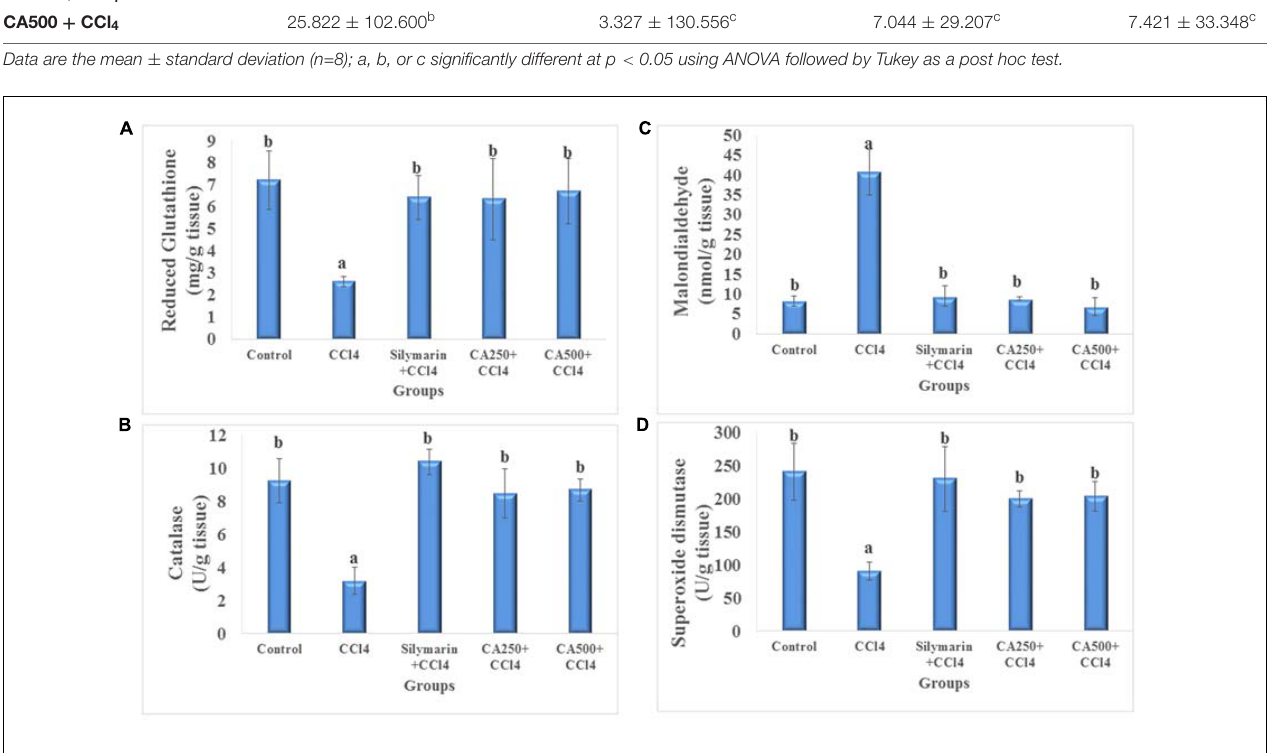
FIGURE 2 | In vivo antioxidant activity of reference drug silymarin, CA250 and CA500 against CCl 4 induced hepatotoxicity on liver tissue levels of (A) reduced glutathione, (B) malondialdehyde, (C) catalase, and (D) superoxide dismutase. Data are the mean ± standard deviation ( n = 8); a or b significantly different at p < 0.05 using ANOVA followed by Tukey as a post hoc